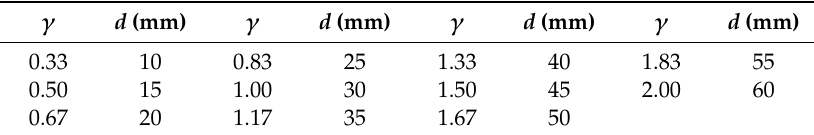
Table 2. Correspondence of γ and d .